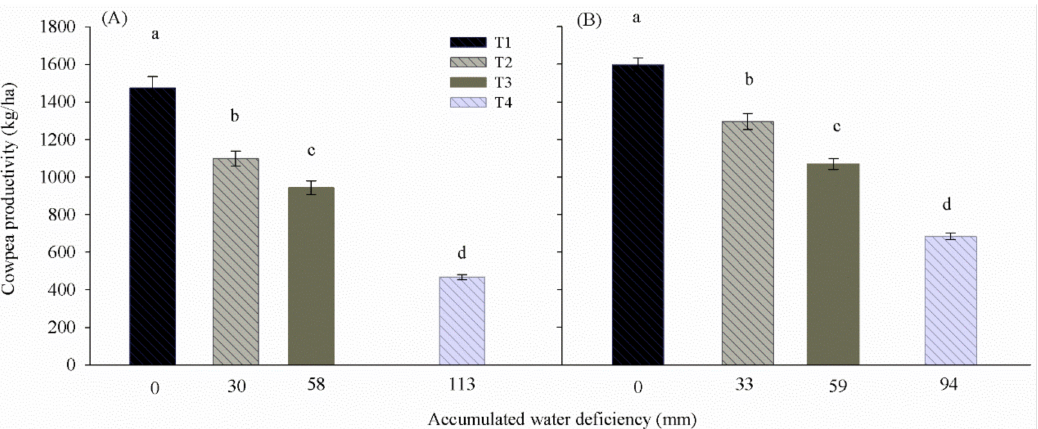
Figure 6. Productivity of cowpea plants in the 2015 ( A ) and 2016 ( B ) experiments, Castanhal, Par á . (Bars represent standard error.) Columns followed by the same letter do not differ statistically between treatments (Tukey teste, p ≤